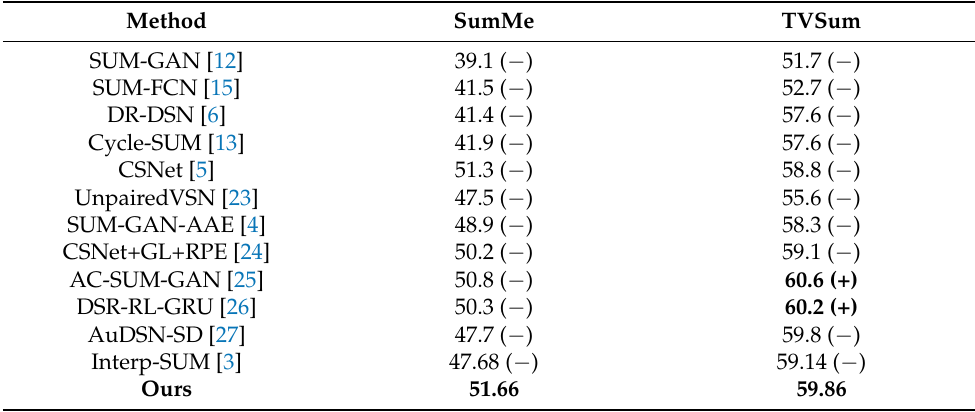
Table 3. Results (F-measure, %) of the comparison among the unsupervised-based methods tested on SumMe and TVSum. +/ − indicates better/worse performance than